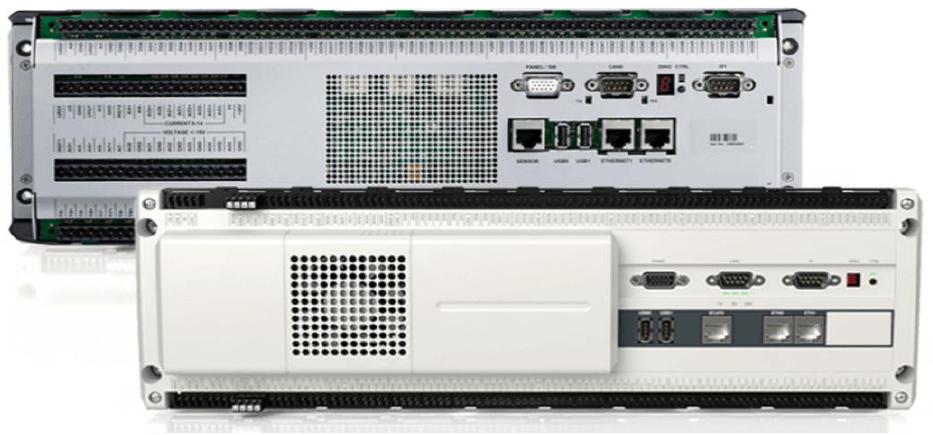
Figure 3. Controller-A, assembled in the